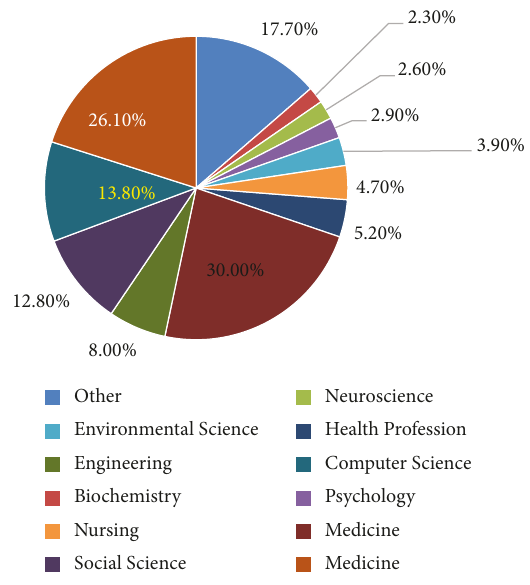
Figure 20: Pie chart depicting article distribution by disciplines for mapping review articles.